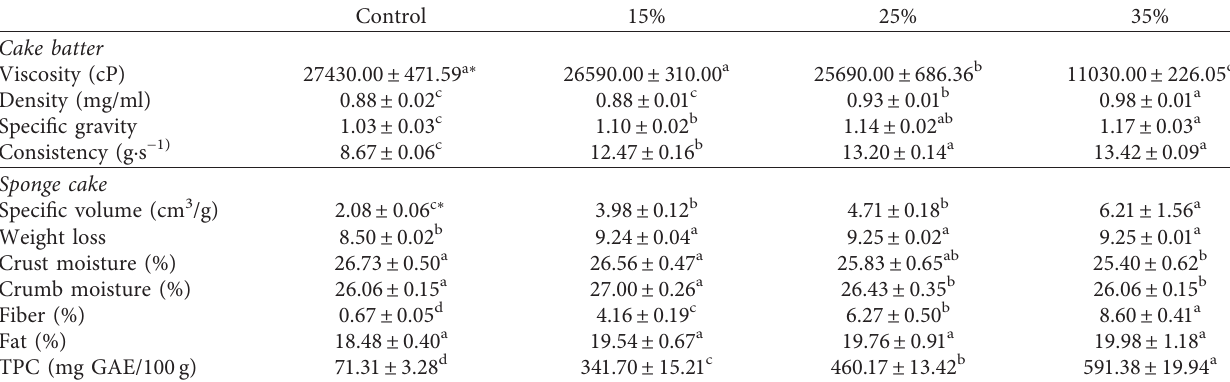
Table 2: Physicochemical properties of cake batters and sponge cakes prepared with different levels of OSP † . Control